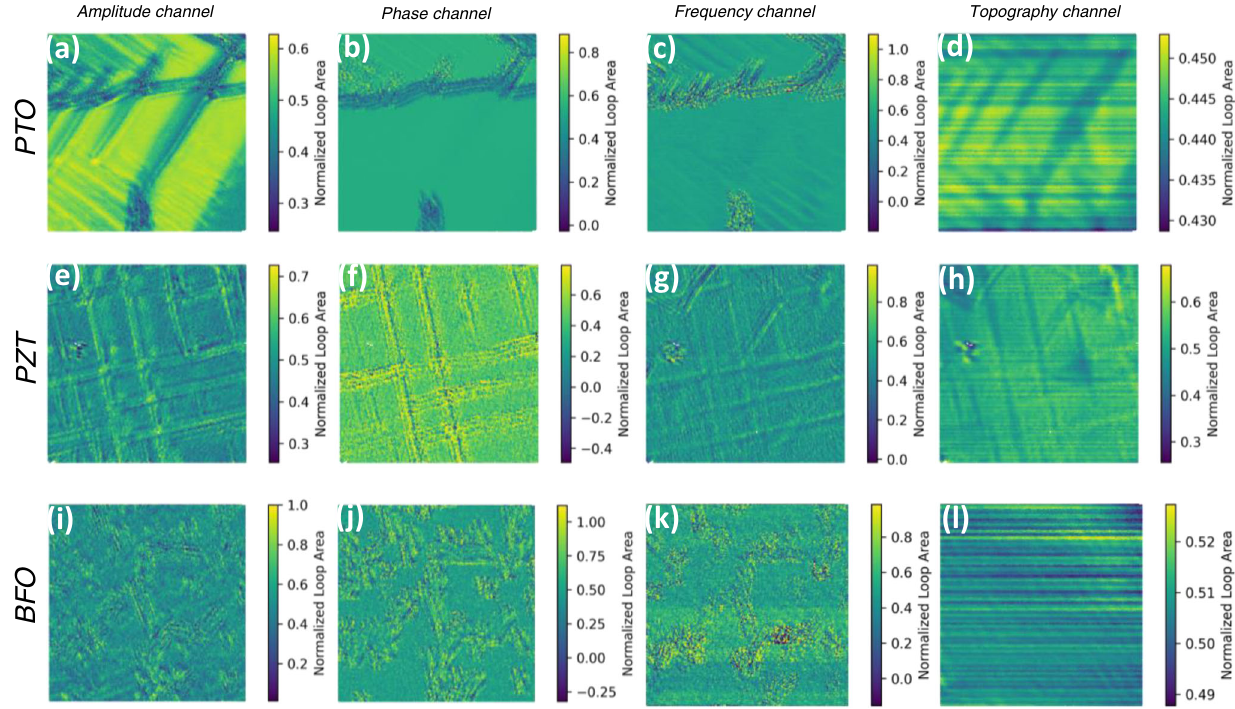
Fig. 5 Ensemble DKL prediction of frequency loop area from each channel after experiment. a – l Ensemble DKL predictions of PTO, PZT, and BFO, respectively. a , e , i DKL prediction of frequency loop area from amplitude image; b , f , j DKL prediction of frequency loop area from phase image; c , g , k DKL prediction of frequency loop area from resonance frequency image; d , h , l DKL prediction of frequency loop area from topography image.